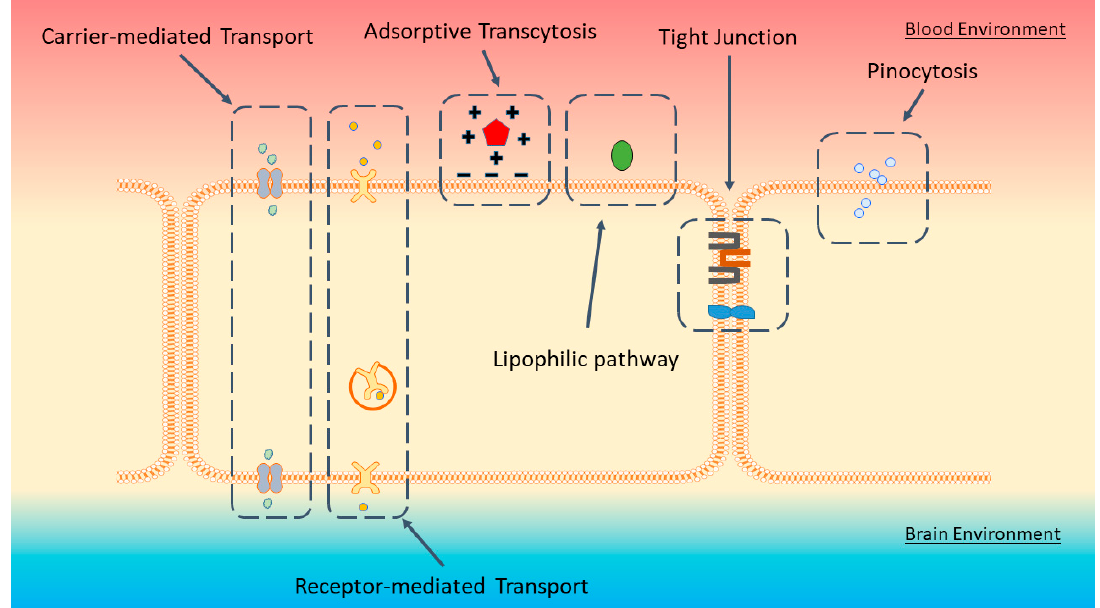
Figure 1. Summary of BBB anatomy and transport pathways. Passage of large molecules from the blood to the brain environments are limited to the carrier-mediated and receptor-mediated transport systems, adsorptive transcytosis, the lipophilic pathway, and pinocytosis. Tight junctions in between cells and the lack of fenestrations restrict free movement of molecules. Figure adapted from reference [6].